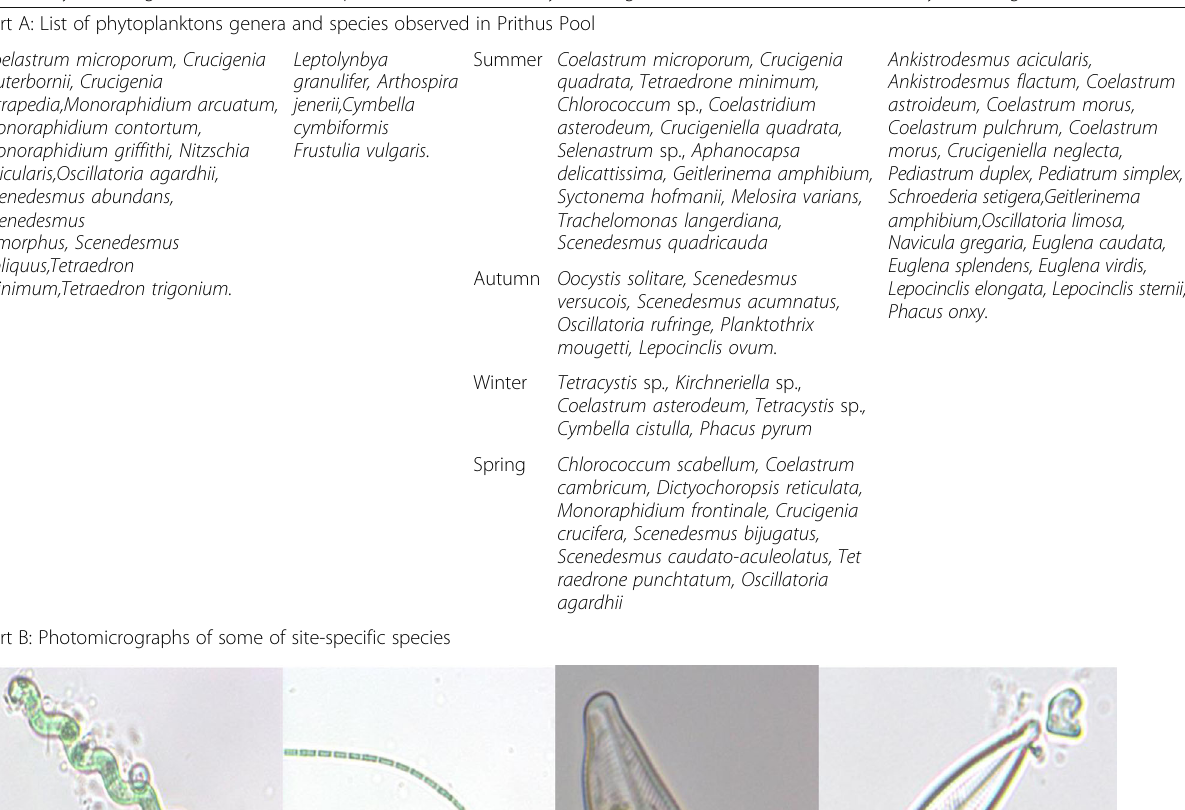
Table 5 Phytoplankton -map (P-map) for Prithus Pool Commonly occurring Site- specific Seasonally occuring Rarely occurring Part A: List of phytoplanktons genera and species observed in Prithus Pool Coelastrum microporum, Crucigenia lauterbornii, Crucigenia tetrapedia,Monoraphidium arcuatum, Monoraphidium